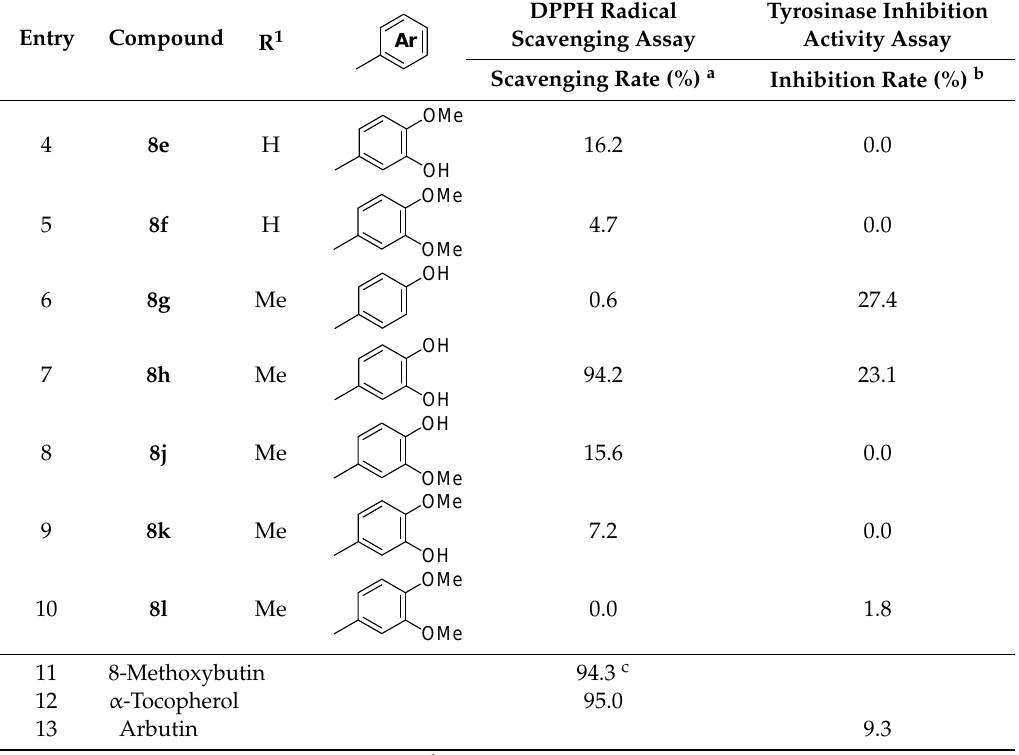
Table 2. The DPPH radical scavenging assay and tyrosinase inhibition activity assay of flavanones 8a – l.